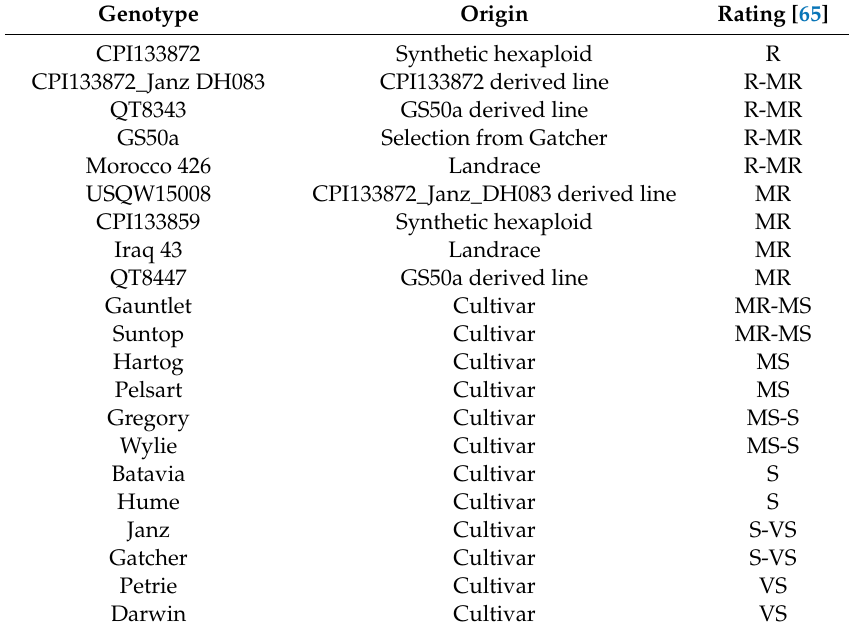
Table 2. Origin and resistance rating to Pratylenchus thornei for wheat